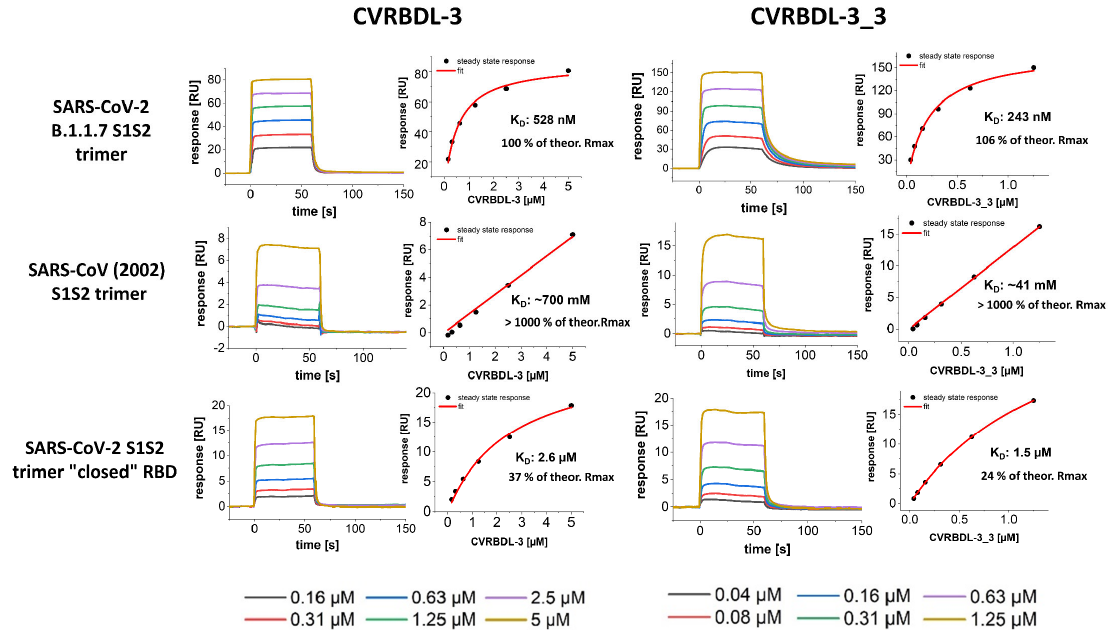
Figure 9. SPR affinity measurement of CVRBDL ‐ 3 and tail ‐ to ‐ tail construct CVRBDL ‐ 3_3 on the CoV-2 B.1.1.7 trimer spike, SARS-CoV (2002) trimer and the SARS-CoV-2 “closed” RBD trimeric SARS ‐ CoV ‐ 2 B.1.1.7 trimer spike, SARS ‐ CoV (2002) trimer and the SARS ‐ CoV ‐ 2 “closed” RBD tri ‐ meric spike. The spike constructs were immobilized on a polycarboxylate matrix by coupling via primary amino groups with sulfo ‐ NHS ester at pH 5.5 (200 HCM, Xantec, GE). Measurements were performed in 10 mM HEPES (pH 7.4), 150 mM NaCl, 3 mM EDTA, 0.005% Tween ‐ 20 in a T200 device